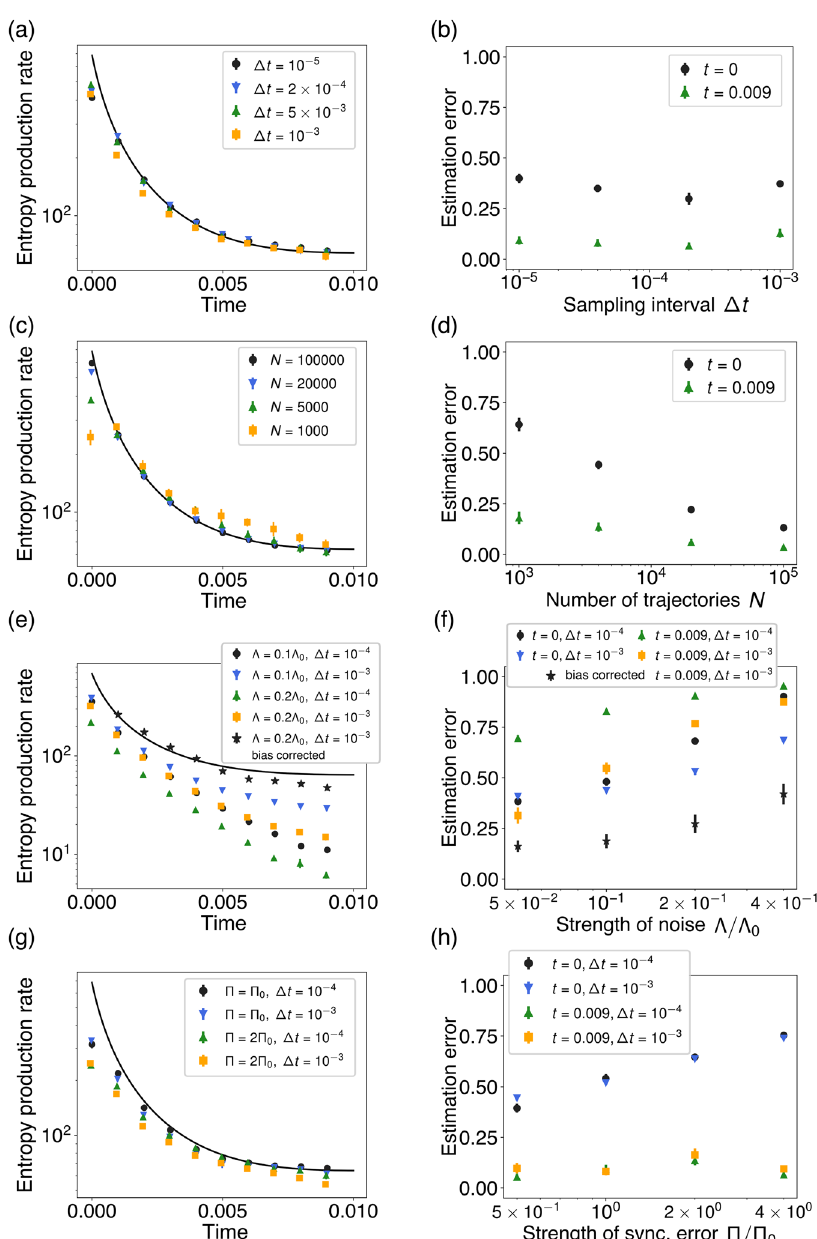
Fig. 3 Estimation with imperfect data in the adaptation model. Four variations from ideal data are considered: ( a )( b ) with different sampling intervals Δ t , ( c )( d ) with a different number of trajectories N , ( e )( f ) with the measurement noise (Eq. (19)), and ( g )( h ) with the synchronization error (Eq. (20)). ( b )( d )( f )( h ) are the error analysis of ( a )( c )( e )( g ) between the estimated and the true entropy production rate ( : ¼ j b σ ð t Þ (cid:3) σ ð t Þj = σ ð t Þ ) at two time instances t = 0 and 0.009. The strength of the measurement noise Λ is shown in units of Λ m in the stationary state at t > 0. The strength 0 , the standard deviation of of the synchronization error Π is shown in units of Π 0 , the approximate time instance when the entropy production rate becomes half of its initial value. The black line is the true entropy production rate as used in Fig. 2. a , b The estimation is robust against the choice of the sampling interval. c , d The number of trajectories required for the convergence is large near the initial highly non-stationary time. e , f As for the strength of the measurement noise Λ increases, the estimate reduces because of the effective increase of the diffusion matrix. A larger time interval as well as correcting the bias (via Eq. (S4) of Supplementary Note 1) substantially mitigate this effect. g , h The estimate becomes an averaged value in the time direction. In contrast to ( e )( f ), the time interval dependence is small. For ( a ) – ( h ), the simple dual representation (Eq. (10)) is used for training the model function, and the variance-based estimator (Eq. (14)) is used for the estimation. The mean of ten independent trials are plotted, and the error bars correspond to the standard deviation ffiffiffiffiffi p divided by 10 . The system parameters are the same as those in Fig. 2 except τ obs =